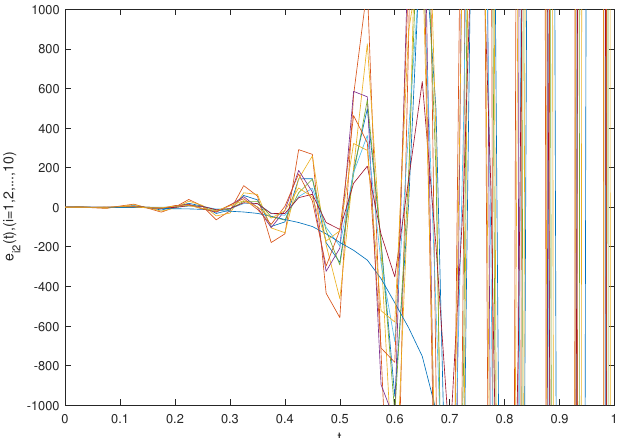
Figure 13. Synchronization errors e i 2 ( i = 1,2, · · · ,10 ) of the fractional-order system (34) and (35) without the controllers.